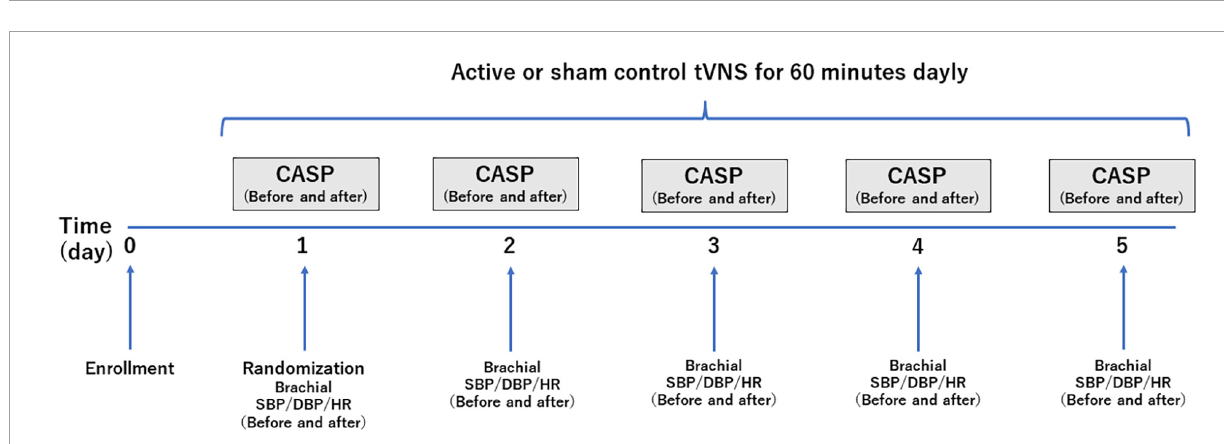
FIGURE3 A schematic representation of the study design and timeline of hemodynamic measurements. tVNS, transcutaneous vagus nerve stimulation; CASP, central aortic systolic pressure; SBP, systolic blood pressure; DBP, diastolic blood pressure; HR, heart rate.